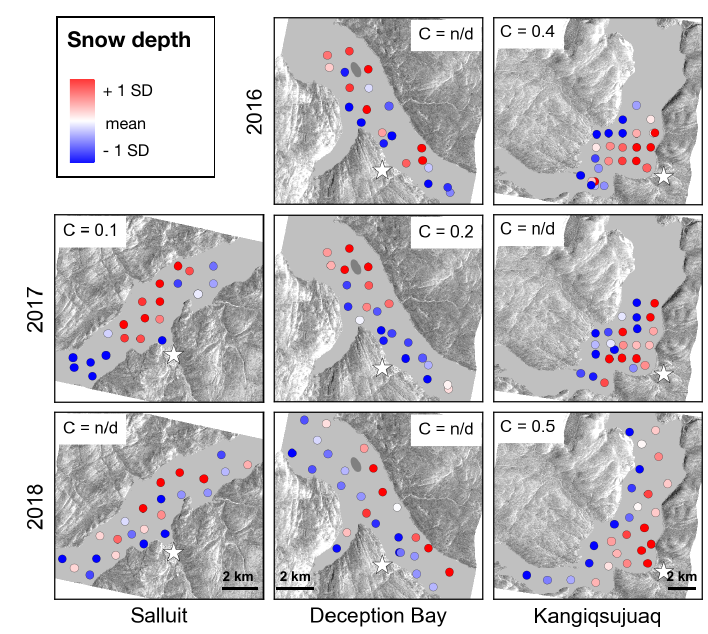
Figure 3. Standardized end-of-winter snow depth for Salluit (left), Deception Bay (center), and Kangiqsujuaq (right), for 2016 (top), 2017 (middle) and 2018 (bottom). Markers are color-coded according to the measurement’s deviation from their dataset’s mean: thinner than the mean by one standard deviation (SD) or more (blue), equal to the mean depth (white) or greater than the mean by one standard deviation or more (red). Geary’s C is annotated in each case, with either the statistic’s value or n/d if its p -value was above 0.05. In the background for terrain are 2015 RADARSAT-2 HH images from December 19, 26, and 23, respectively, with the sea ice masked out in gray. White stars indicate Salluit, wharves in Deception Bay, and Kangiqsujuaq. Moosehead Island is marked by a gray ellipse.